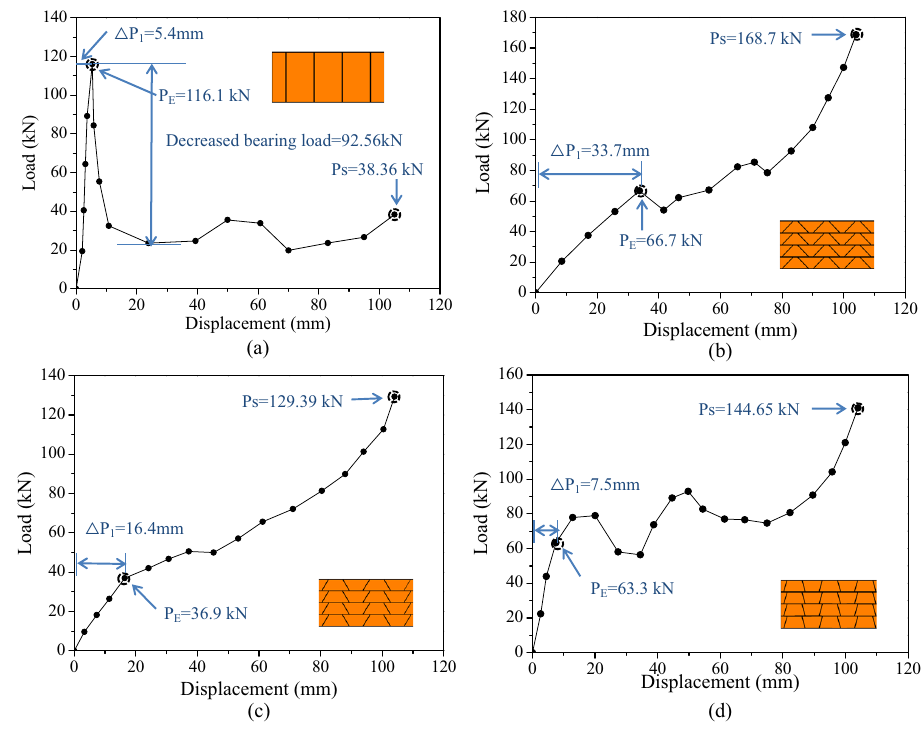
Figure 10: Load – displacement curves of specimens with spatial webs: ( a ) TS - V, ( b ) TS - T - A45, ( c ) TS - T - A60, ( d ) TS - T -